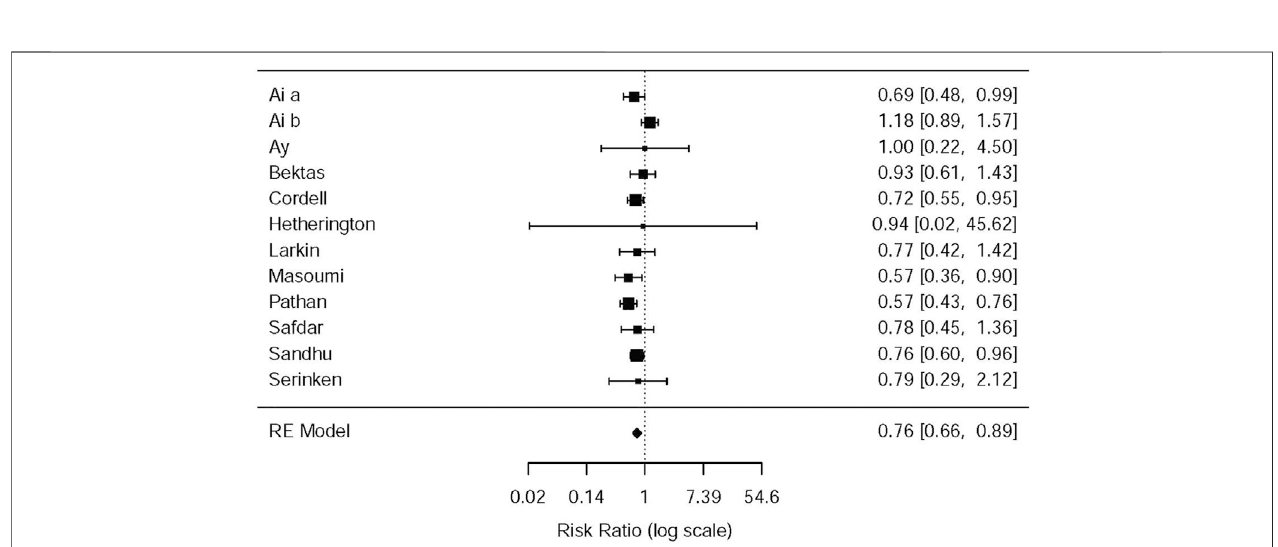
FIGURE 6 | The results of meta-analysis for need for rescue analgesia.